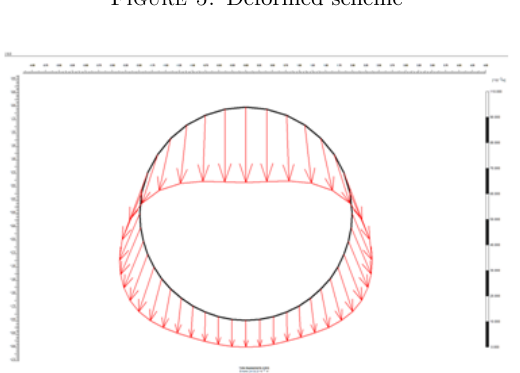
Figure 6. The diagram of shell displacements for sand backfill ( u max = 29 . 32 mm)